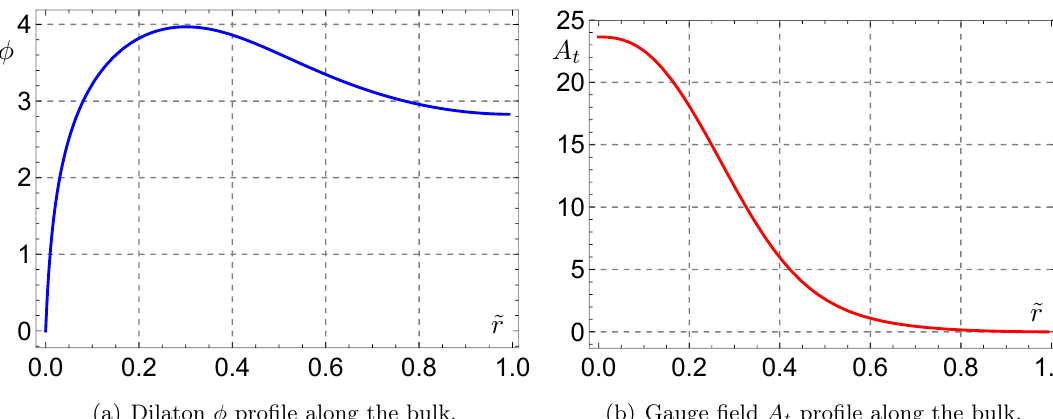
(cid:0)p p 3, (cid:14) = (cid:0) 1 = 3. In this case, the magnetic (cid:12)eld